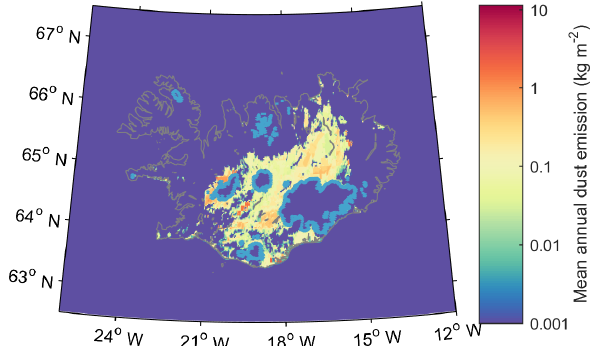
Figure 7. Simulated annual mean dust emission (kgm − 2 ) in years